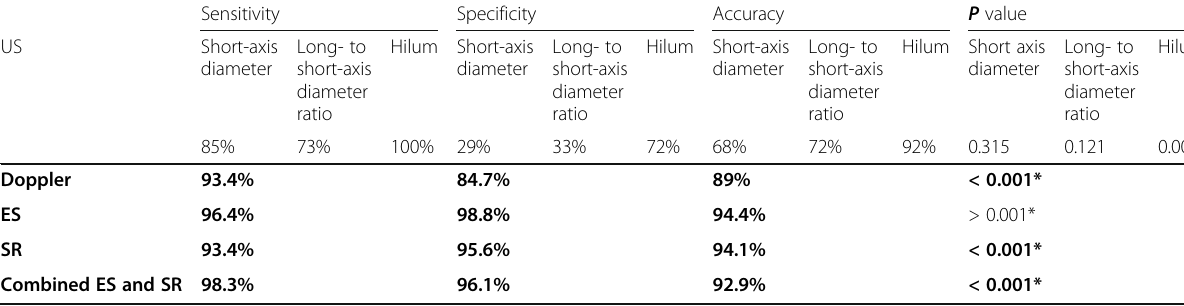
Table 5 Sensitivity, specificity, and accuracy of US, Doppler ES, and SR